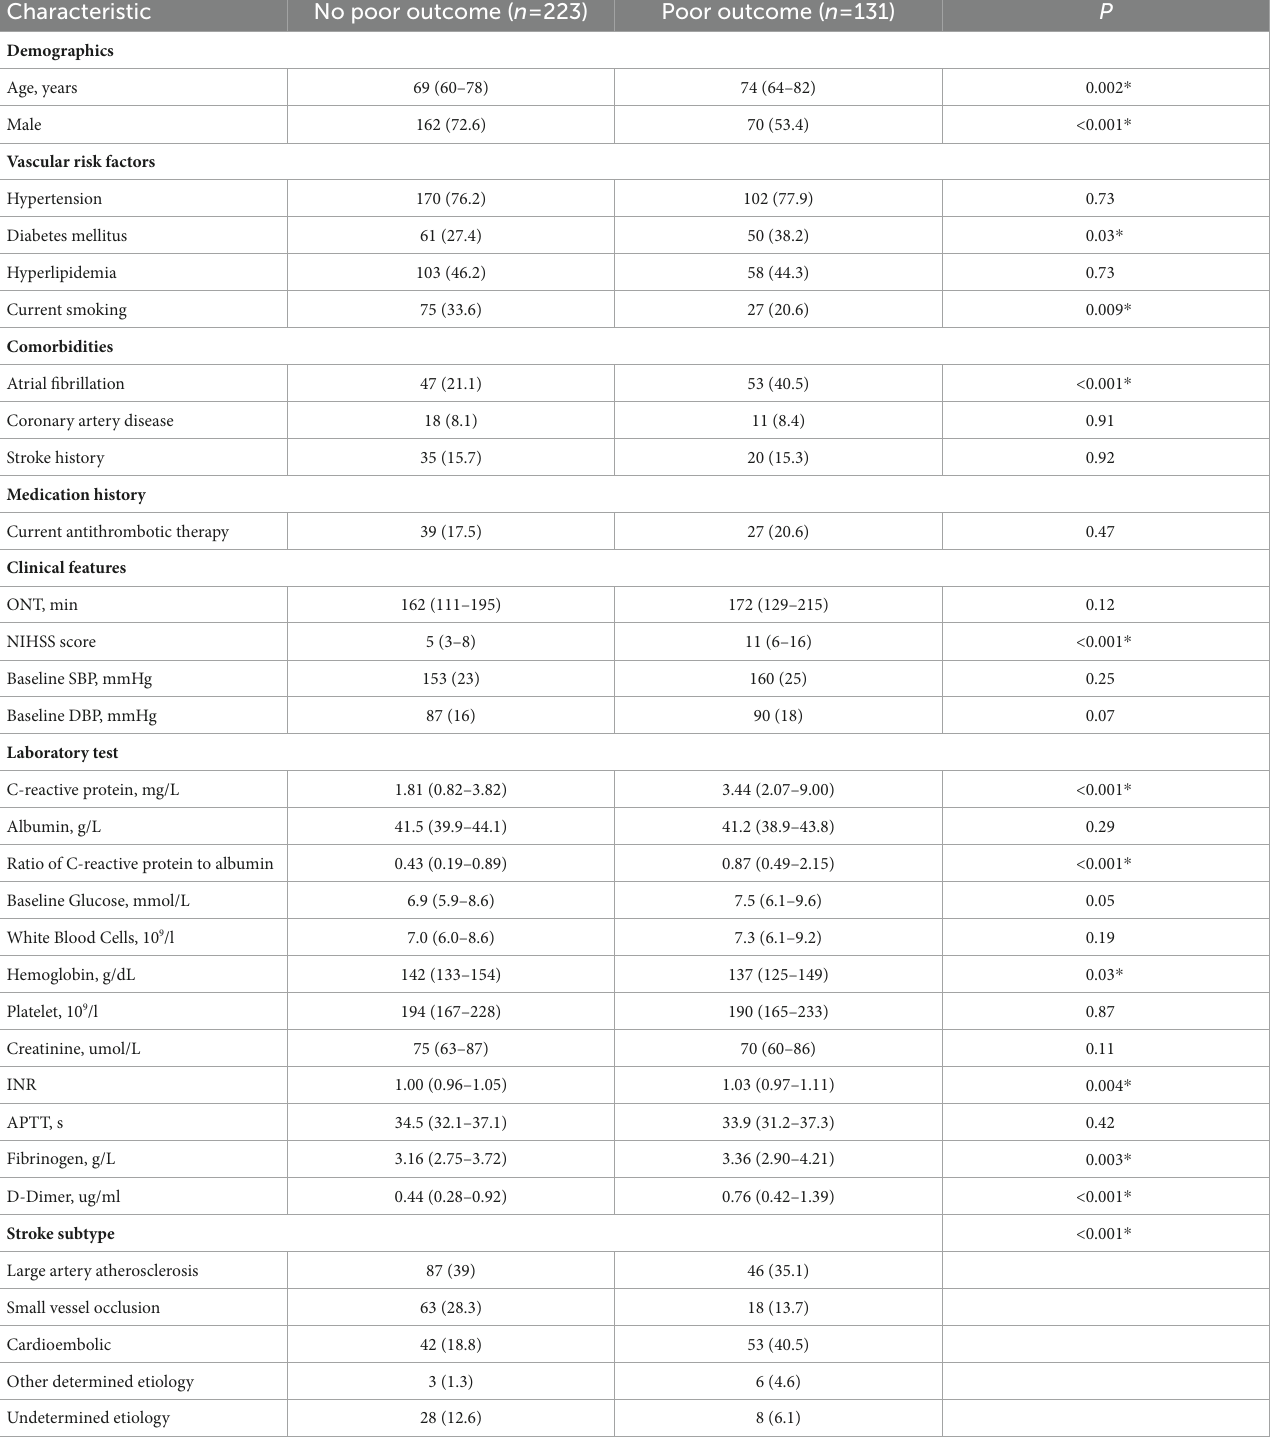
TABLE 2 Comparison of characteristics between patients who experienced poor outcome or not.